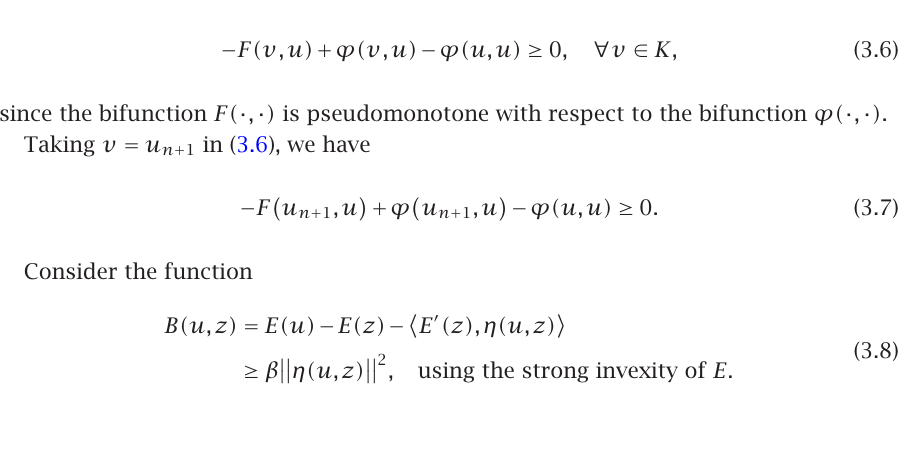
Algorithm 3.3 . For a given u iterative